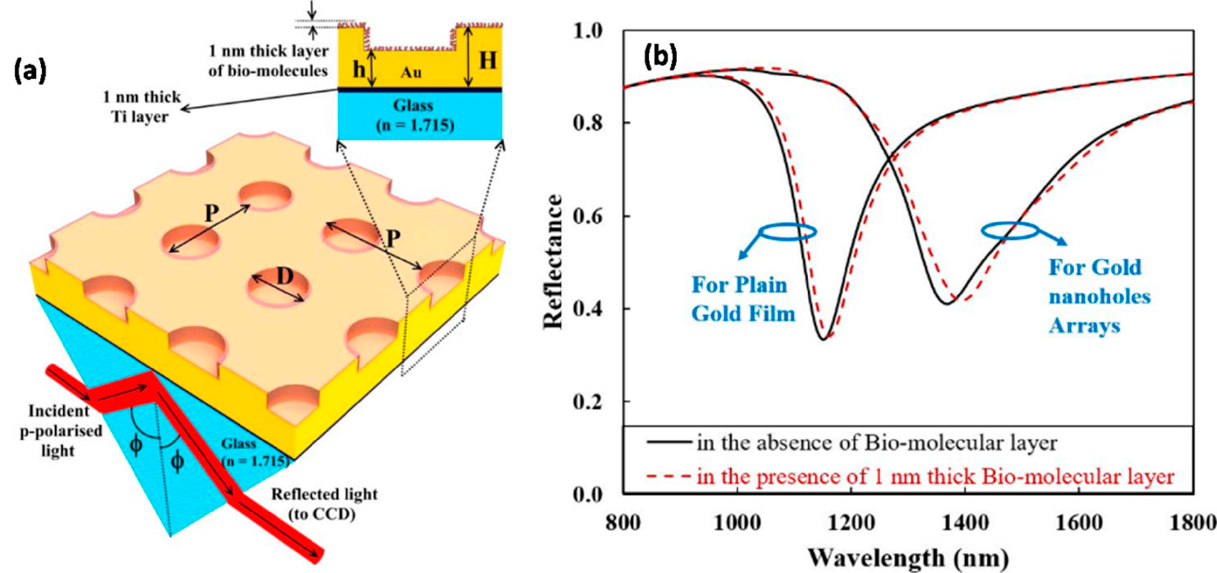
Figure 8. ( a ) Schematic diagram of circular nanohole array over the gold film. P, D, h, and H repre- sent array period, array diameter, gold film thickness below the nanohole, and gold film thickness without the nanohole, respectively. This array is further coated with a 1 nm thick layer of biomole- cules. ( b ) Reflectance spectra calculated for a planar gold film of thickness 60 nm and for gold film structure array with a period (P) and diameter (D) of nanohole array of 50 nm and 30 nm, respec- tively; gold film thickness without nanohole (H) of 60 nm; and gold film thickness below nanoholes of 40 nm. Reproduced with permission from [56].